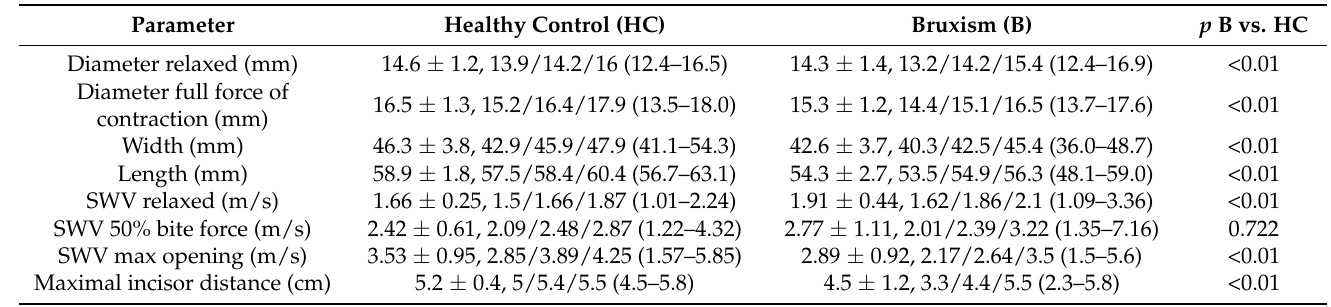
Table 1. Results for the measurements of the musculus masseter, SWV, and maximal incisor distance of healthy controls and bruxism patients. Mean ± standard deviation, percentile 25%/50%/75% (range of all values).